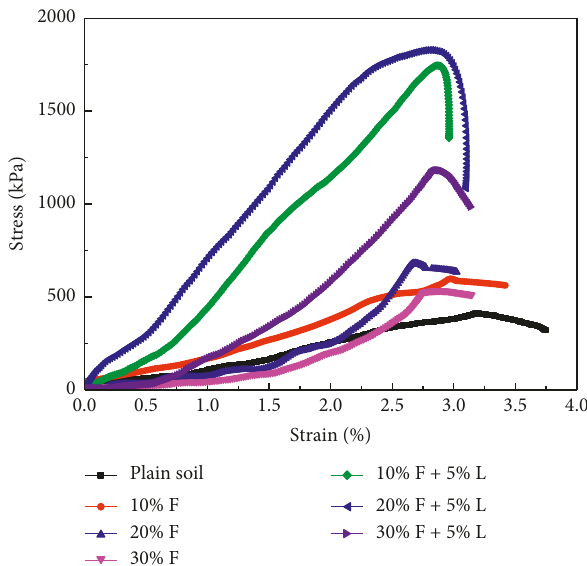
Figure 3: Dynamic compressive stress-strain curves of stabilized soil with different mix